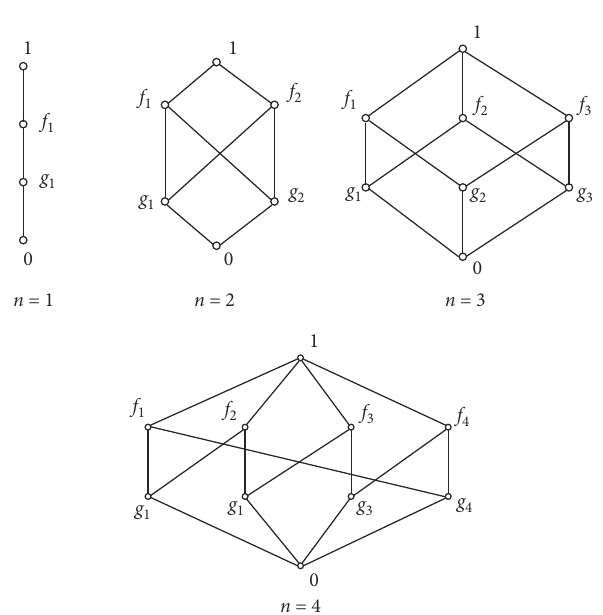
Figure 7: The crown lattices Z